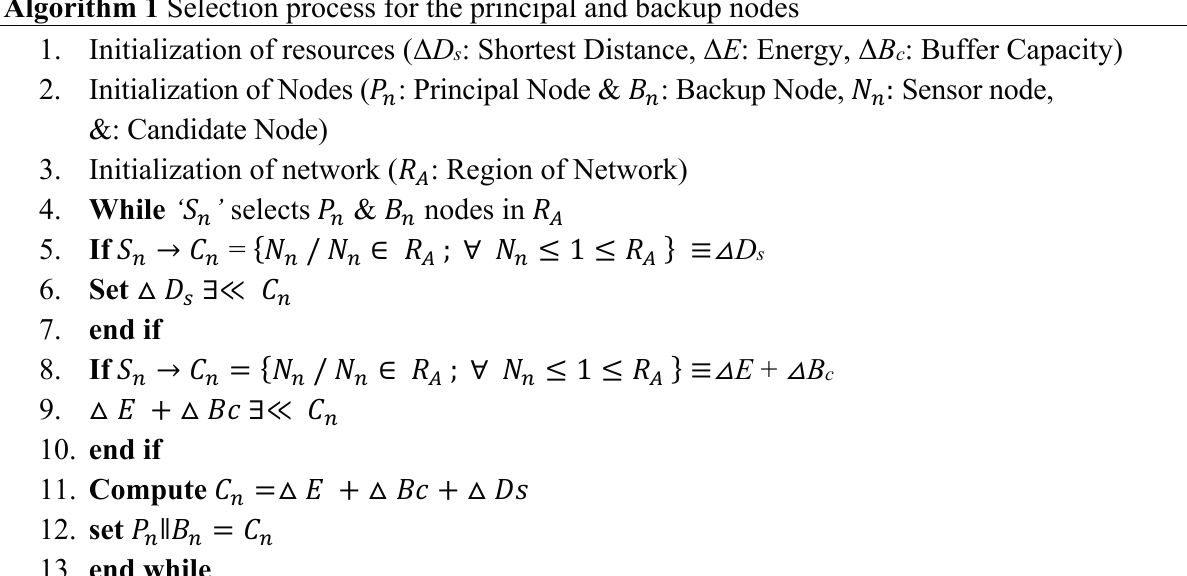
Algorithm 1 Selection process for the principal and backup